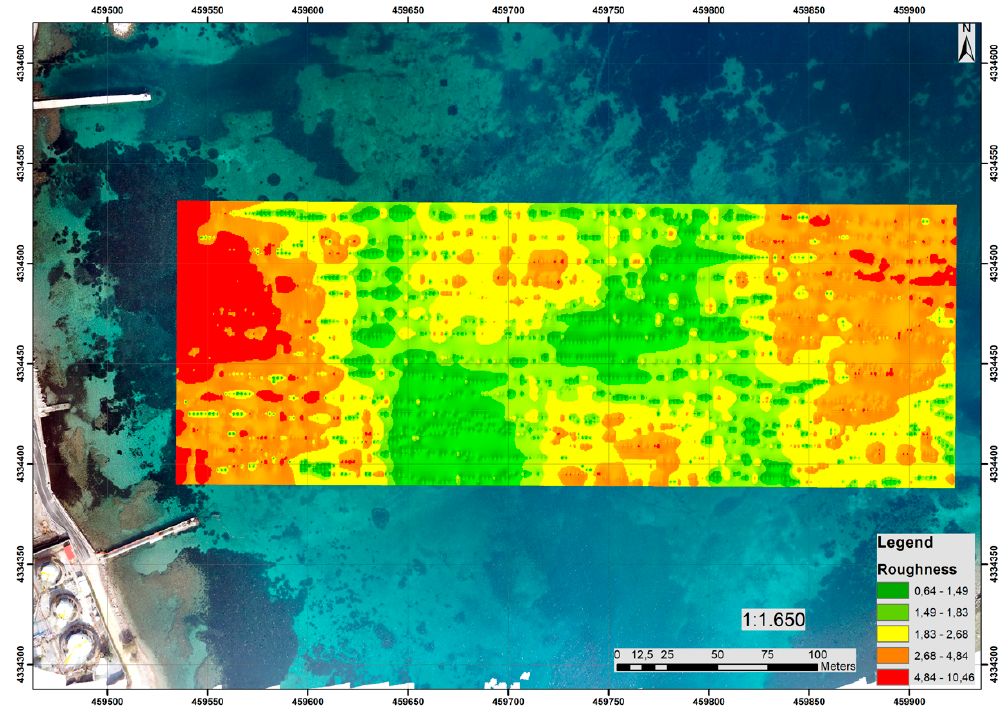
Figure 3. Echo sounder roughness data.